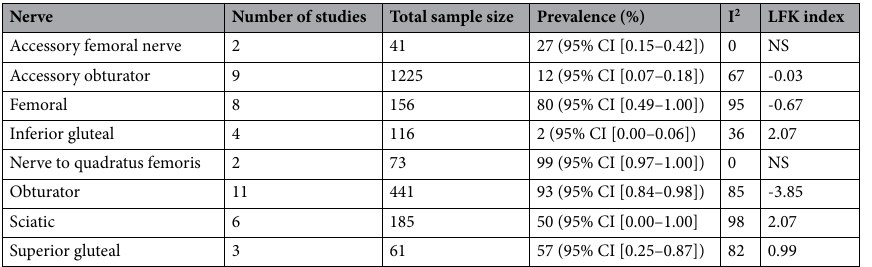
Table 4. Prevalence of nerves innervating the hip capsule. The LFK index of the accessory femoral nerve and nerve to quadratus femoris could not be calculated as only two studies were included in their meta-analysis of prevalence. CI confidence interval, LFK index Luis–Furuva–Kanamori index, NS not